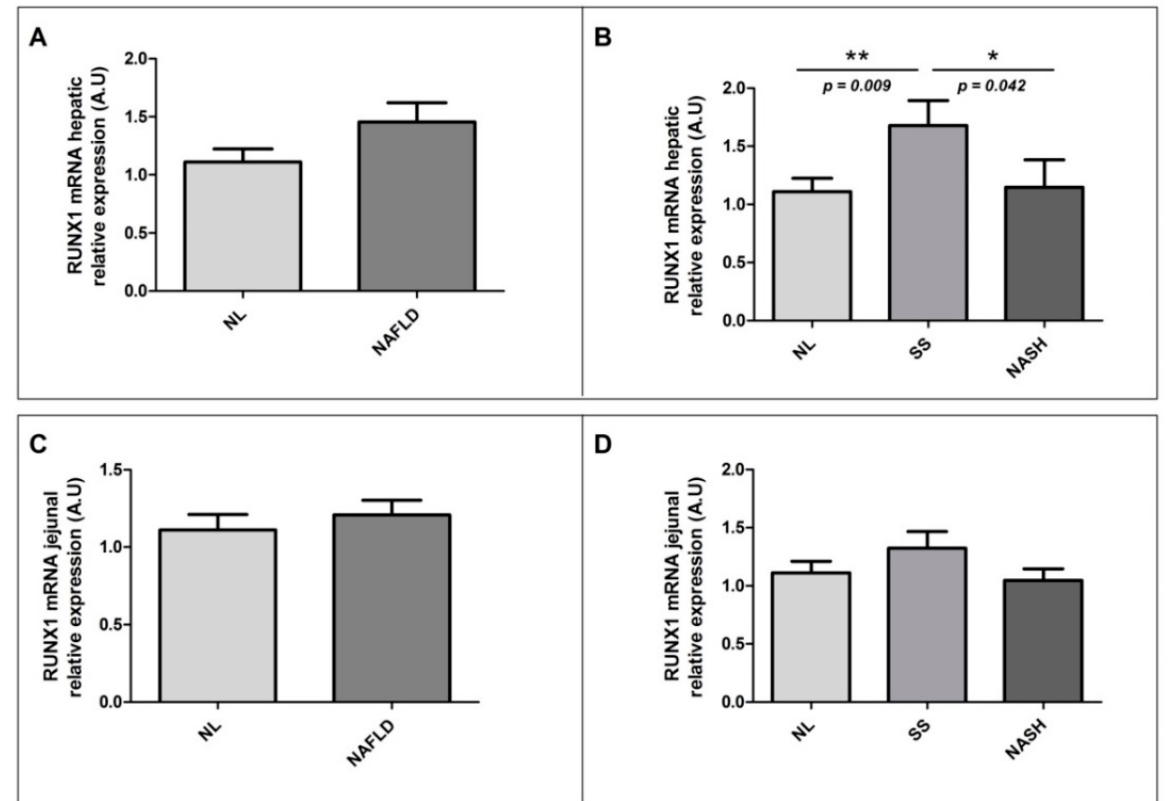
Figure 2. Differential relative mRNA abundance of RUNX1 in liver between ( A ) women with MO with NL histology and women with MO with NAFLD; ( B ) women with MO with NL histology, women with MO with SS, and women with MO with NASH. Differential relative mRNA abundance of RUNX1 in the jejunum between ( C ) women with MO with NL histology and women with MO with NAFLD; ( D ) women with MO with NL histology, women with MO with SS, and women with MO with NASH. A.U, arbitrary units; MO, morbidly obesity; NAFLD, nonalcoholic fatty liver disease; NL, normal liver; SS, simple steatosis; NASH, nonalcoholic steatohepatitis; RUNX1, runt-related transcription factor 1. p < 0.05 was considered statistically significant (* means p < 0.05; ** means p < 0.01).